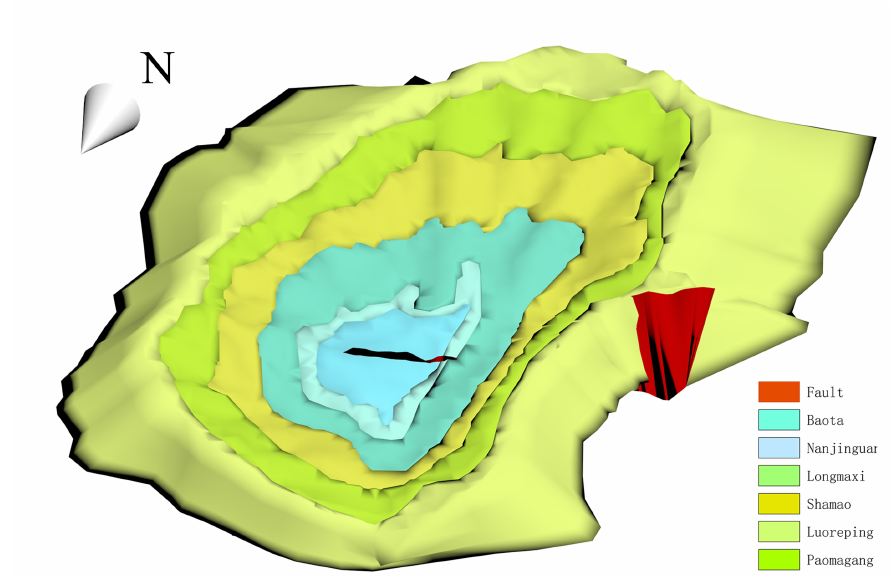
Figure 19. Wulongshan dome structure model including fault